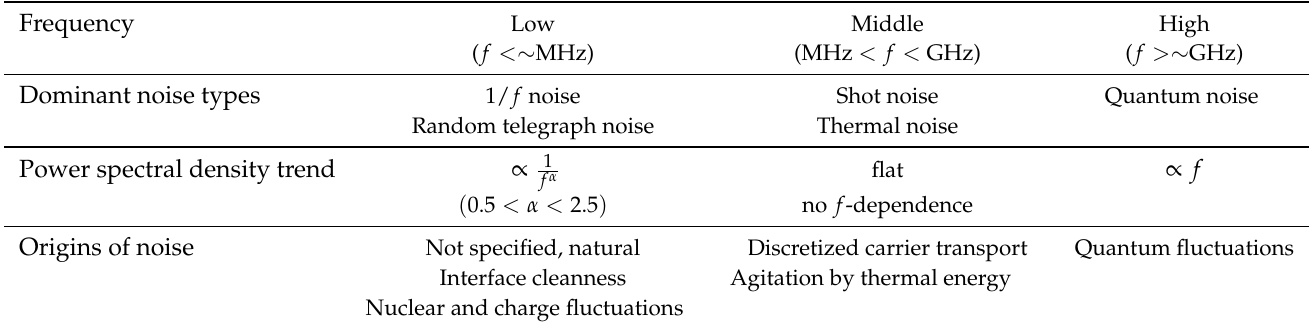
Table 1. Comparison of the frequency-dependent noise sources and